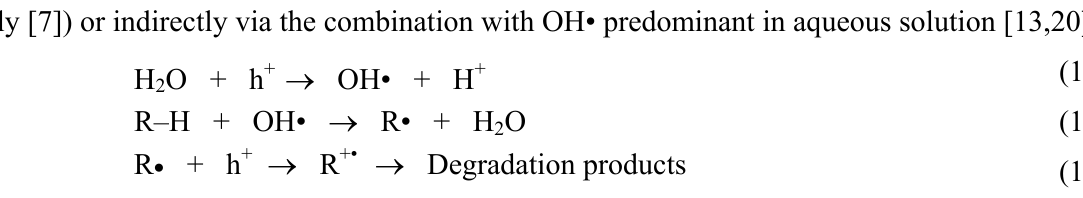
. Adapted from Programa Iberoamericano de 2